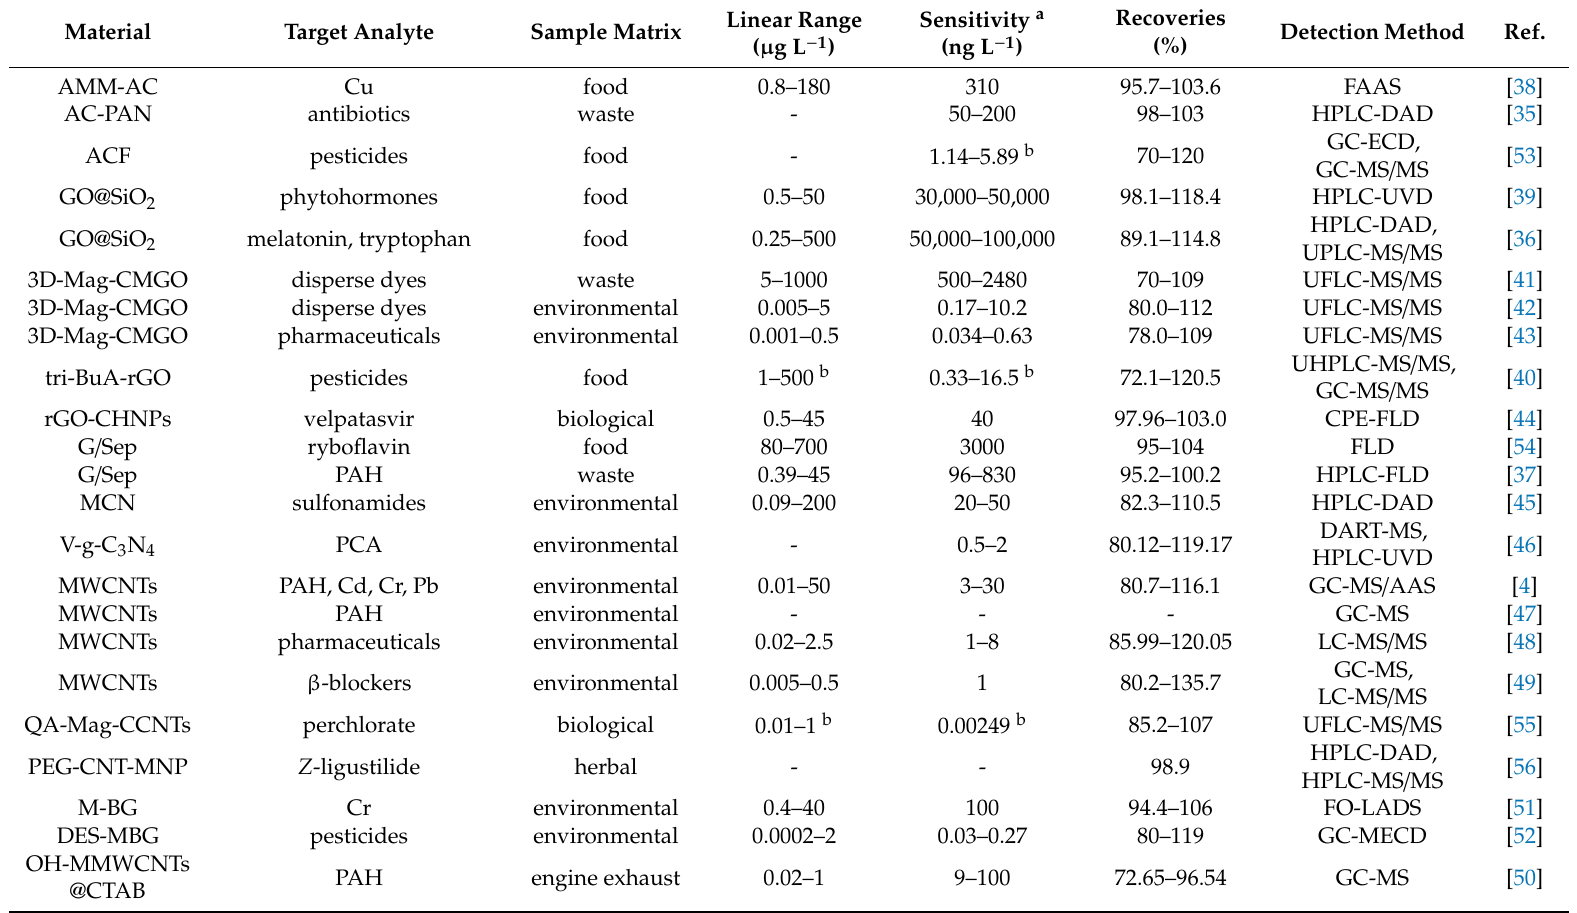
Table 4. Carbon-based